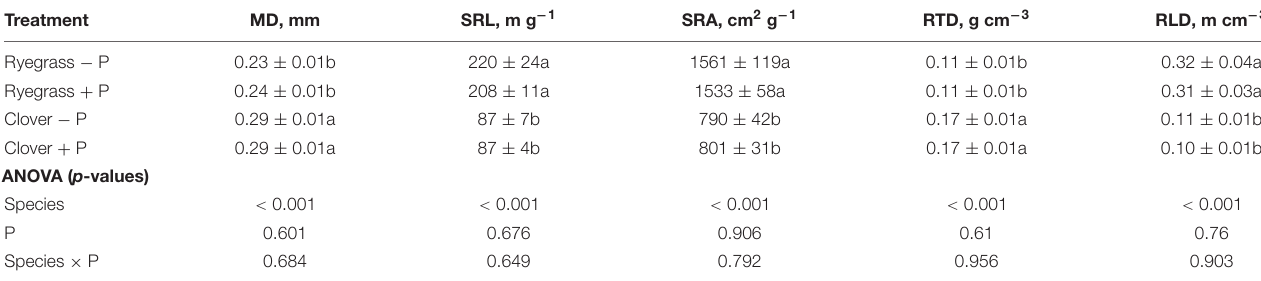
TABLE 1 | Mean diameter (MD), specific root length (SRL), specific root surface area (SRA), root tissue density (RTD), and root length density (RLD) of ryegrass and clover with and without P addition. Treatment MD, mm Ryegrass −